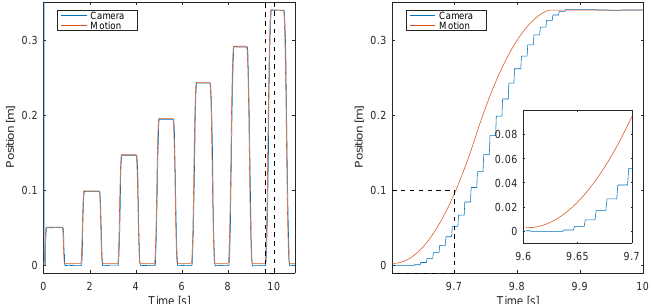
Figure 13. Experiment 1—tracking linear position of the object, 7 step changes were executed ( left ), with a close-up provided on the ( right ).